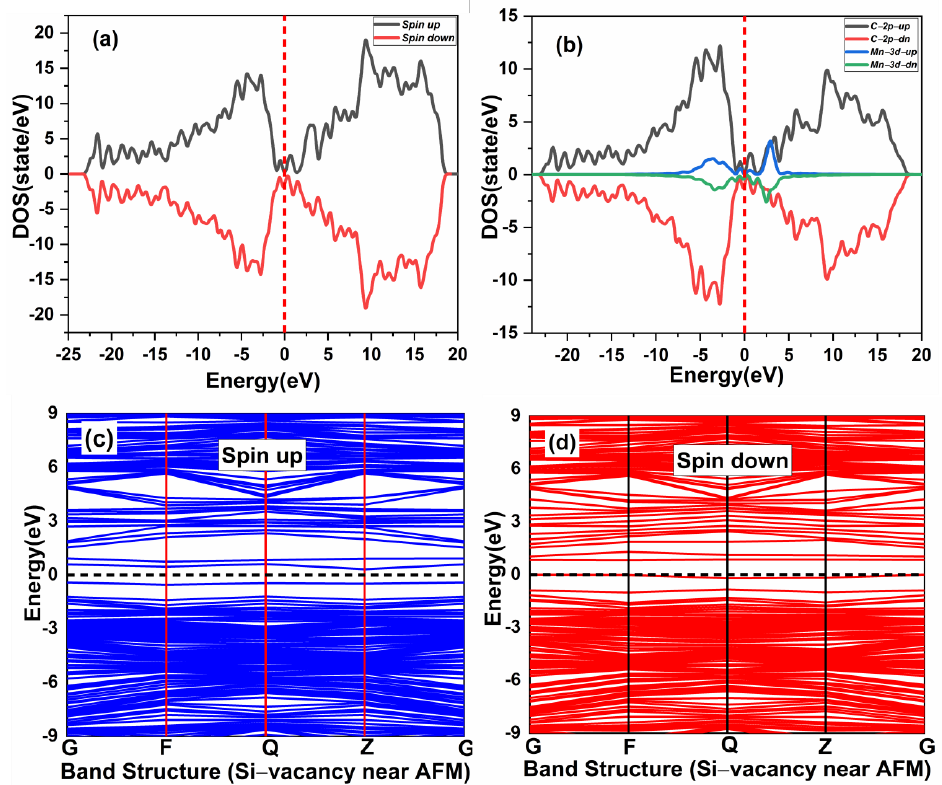
Figure 11. Spin-polarized ( a ) total density of state (TDOS) and ( b ) partial DOS of double ( Mn +2 )- doped 3C-SiC Silicon-vacancy near AFM. ( c ) Blue Spin up and ( d ) red spin down of band Structure. Fermi Level indicated by a red and black dash line.